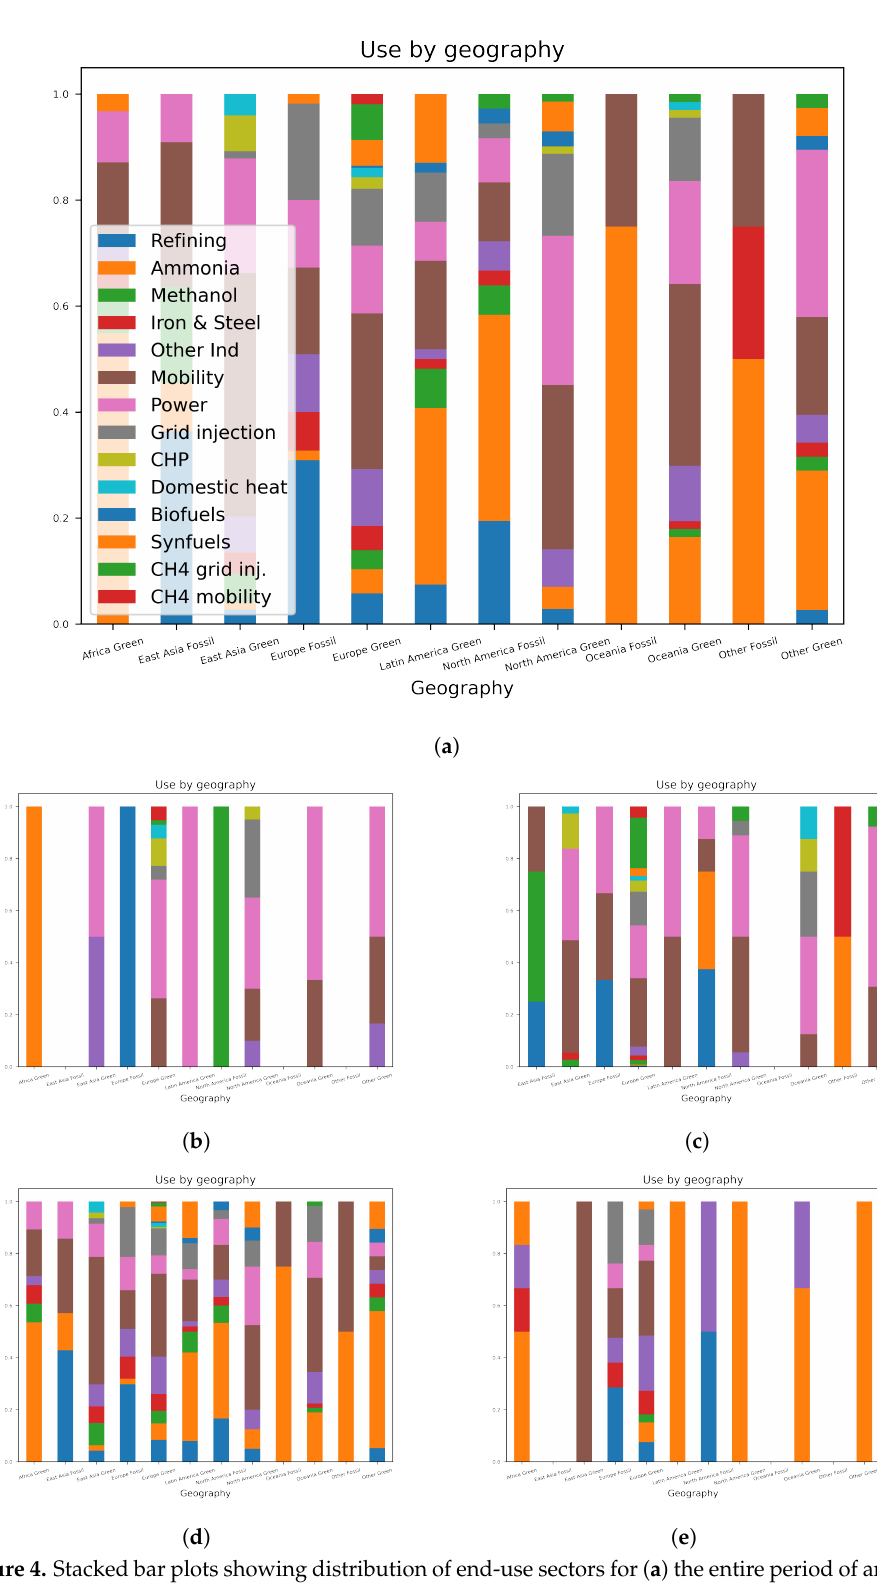
Figure 4. Stacked bar plots showing distribution of end-use sectors for ( a ) the entire period of analysis ( b ) 2000–2009 ( c ) 2010–2019 ( d ) 2020–2029 ( e ) 2030–2039. There are only 12 groups G as there are no fossil plants in Africa or Latin America. Empty bars indicate no plants in that group over that